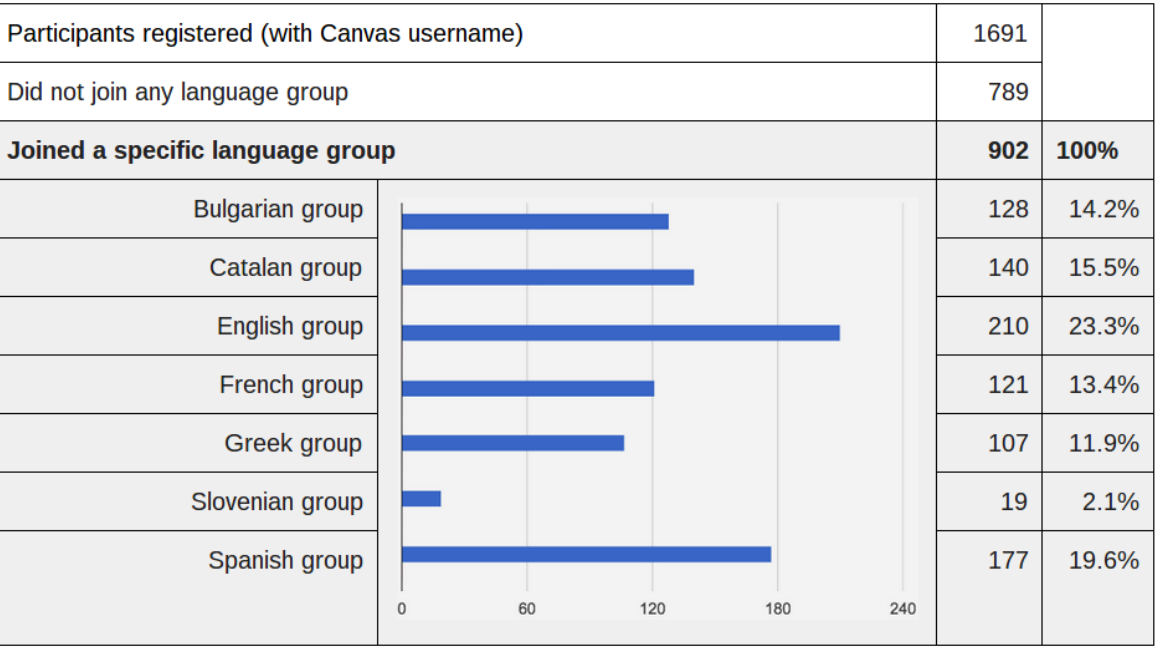
Figure 1 . Distribution of participants in the seven language groups of the HANDSON